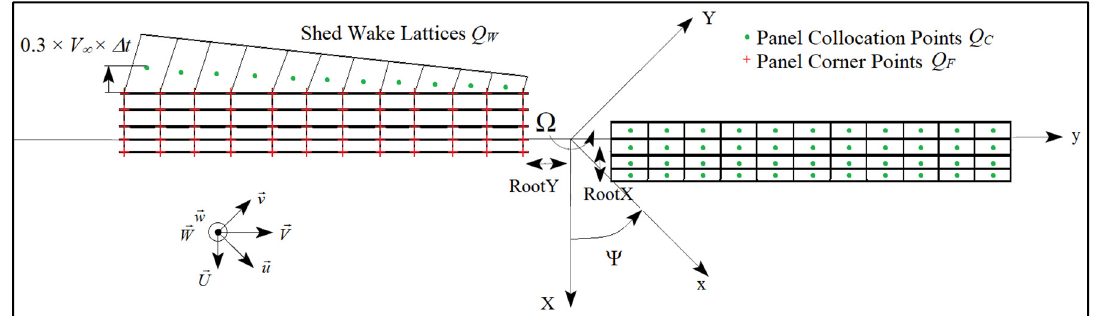
Figure 4. Vortex lattice placement on a rotating two-blade rotor.